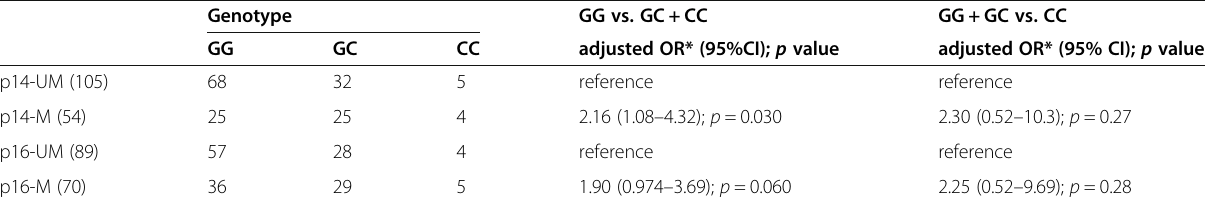
Table 3 Association between MIF rs755622 and CDKN2A methylation